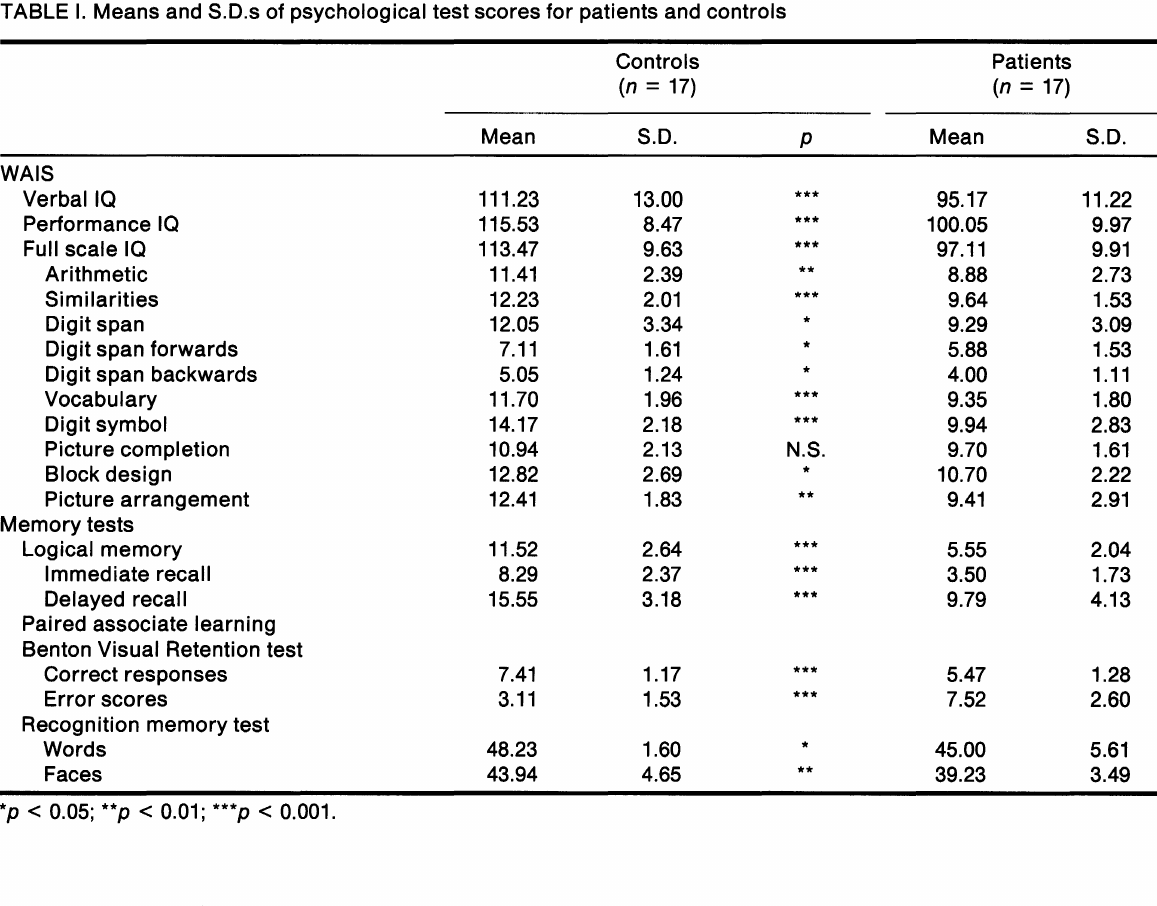
TABLE I. Means and S.D.s of psychological test scores for patients and